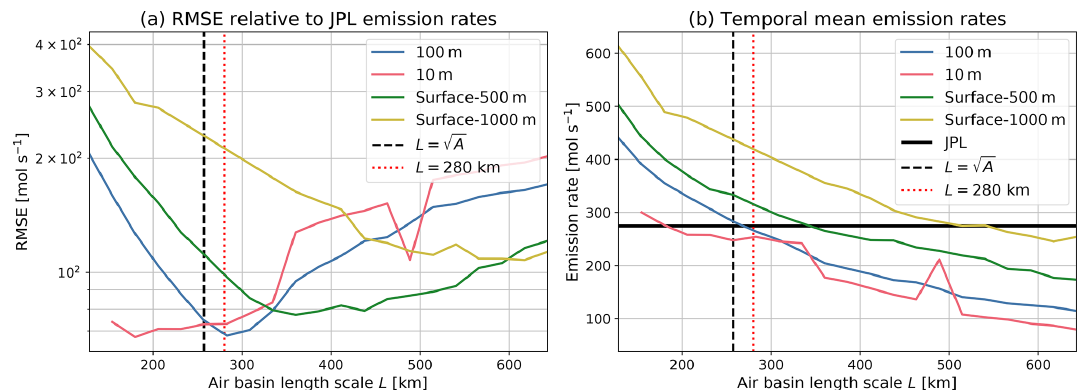
Figure 8. (a) Root mean square error (RMSE) of OMI-based emission rates relative to the monthly JPL chemical reanalysis emission rates for 2005–2019 when using 10, 100, surface–500m, and surface–1000m wind speeds as W in Eq. (5) and a range of L values. (b) Comparison of the temporal mean emission rates estimated from those wind and length scale options with the mean JPL chemical reanalysis emission rate. The square root of the air basin area is shown as the black vertical dashed line, and the selected air basin length scale (280km) is shown as the red vertical dotted